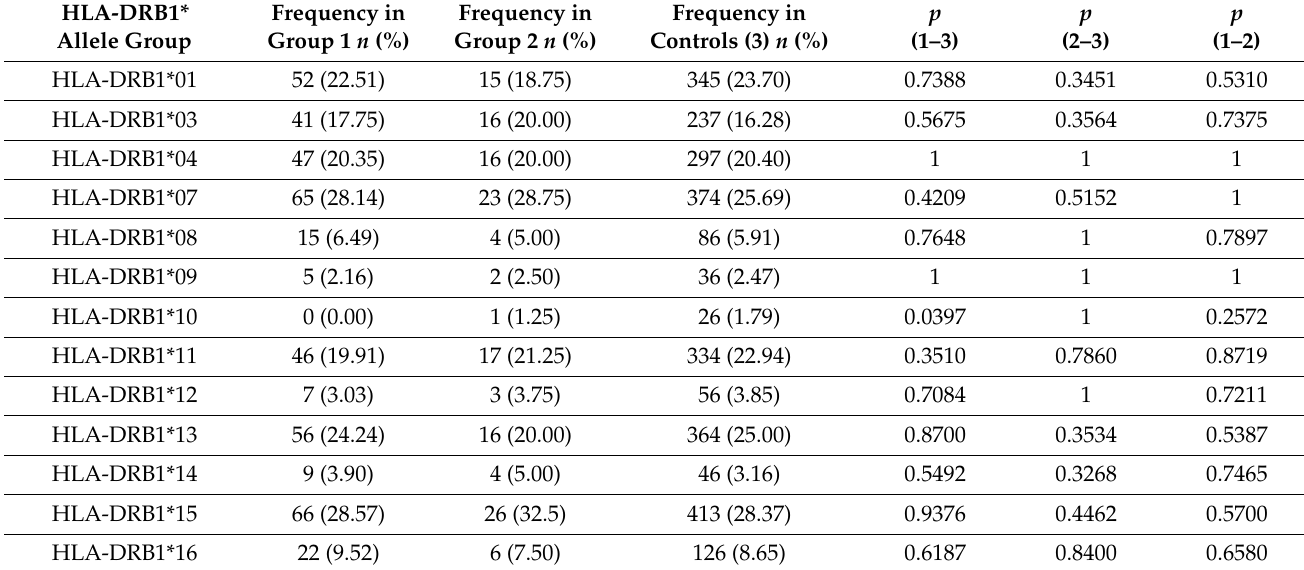
Table 6. Frequency of HLA-DRB1* allele groups in the 1st ( n = 231) and 2nd ( n = 80) COVID-19 convalescent groups compared with controls ( n =